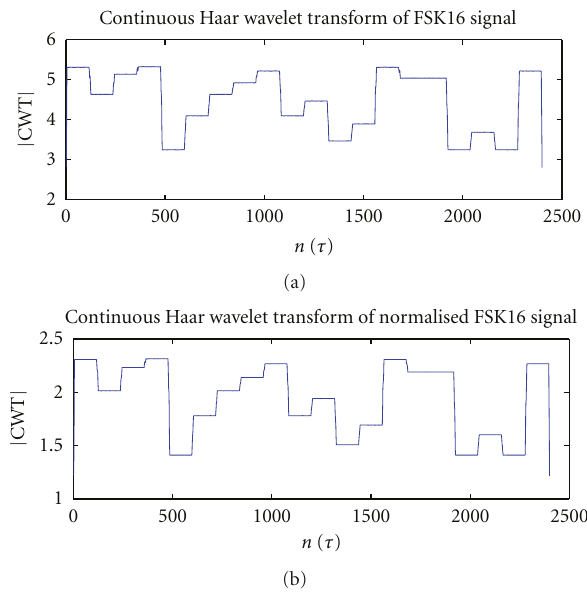
Figure 4: Multi-step wavelet transform of FSK16 signal and its normalized version.